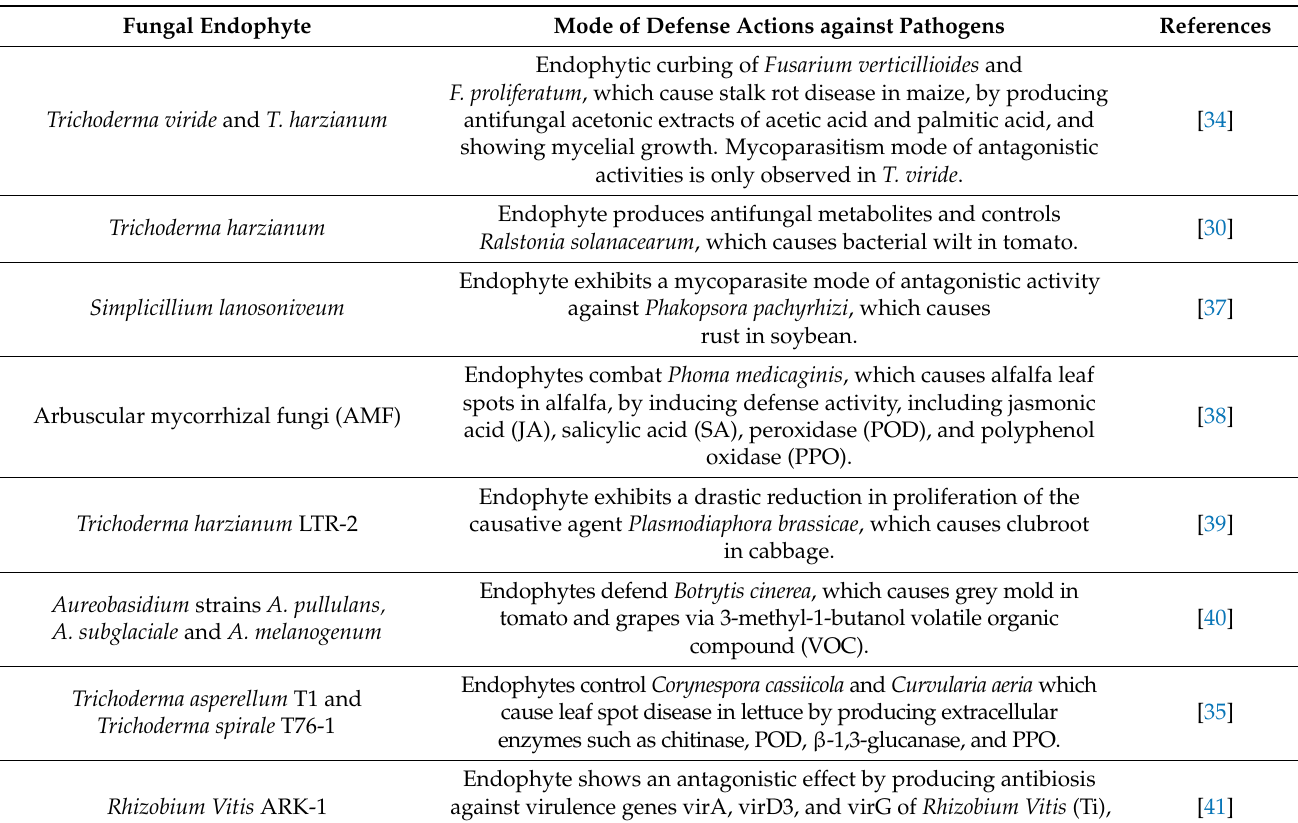
Table 2. Defense mechanism of fungal endophytes against